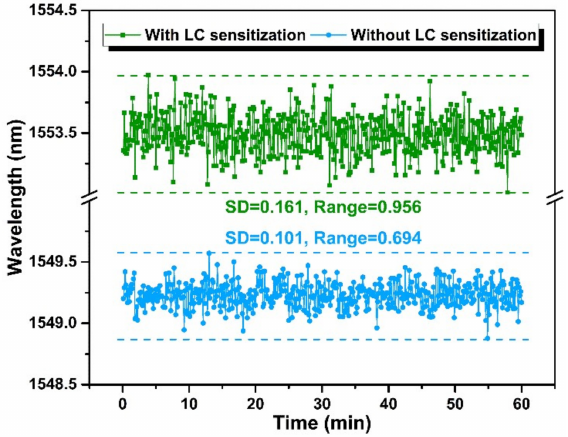
Figure 9. A comparison of the HGMSs with and without LC sensitization in resonant wavelength stability at the cTnI-C concentration of 0